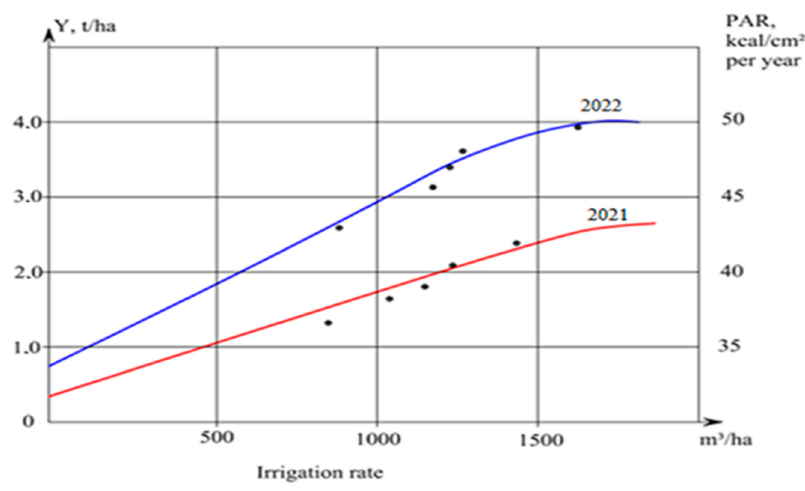
Figure 4. Dependence of spring wheat crop on the irrigation rate and photosynthetic activity of radiation (PAR) [17].